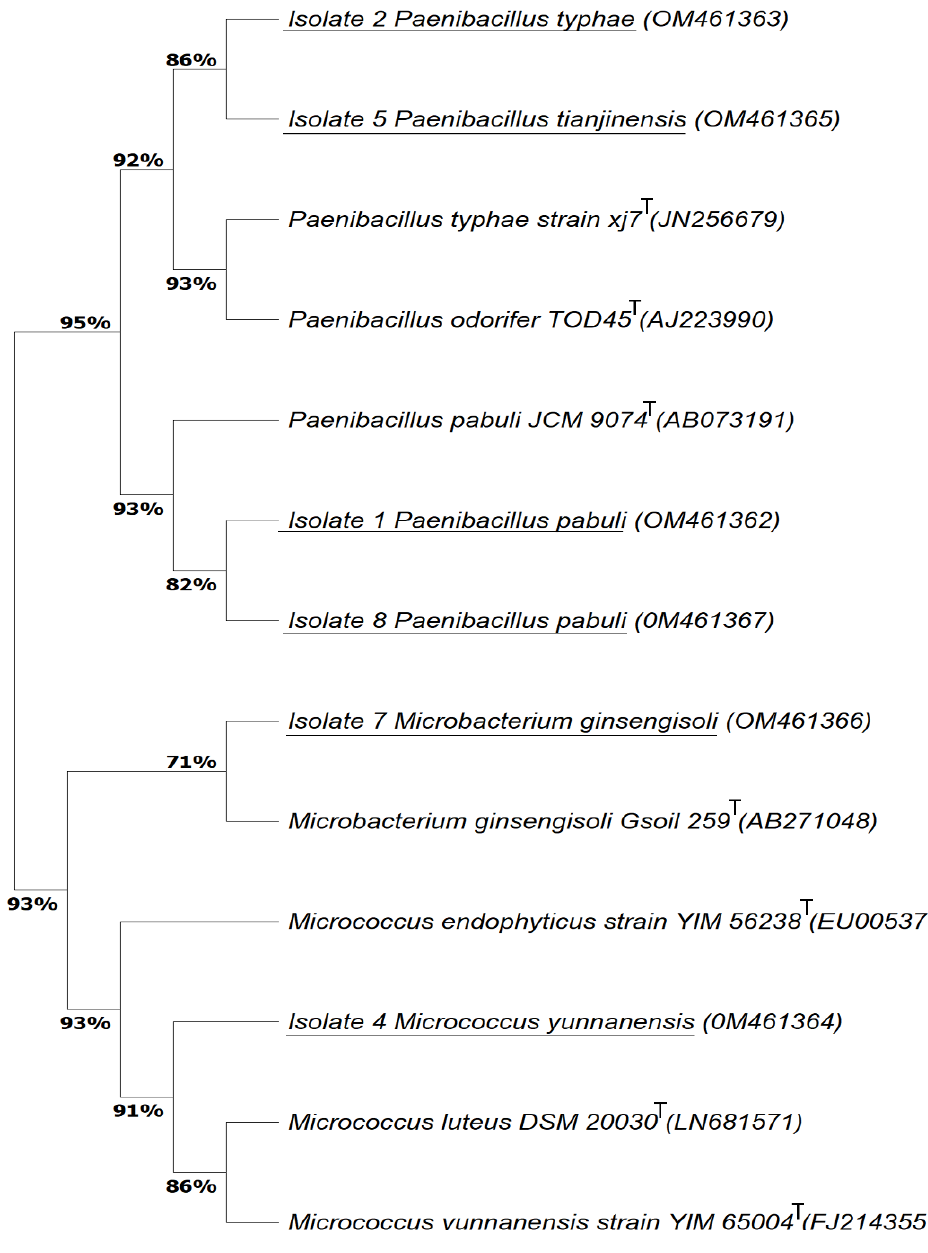
Figure 2. Phylogenetic tree based on the 16S rRNA gene of the bacterial isolates.